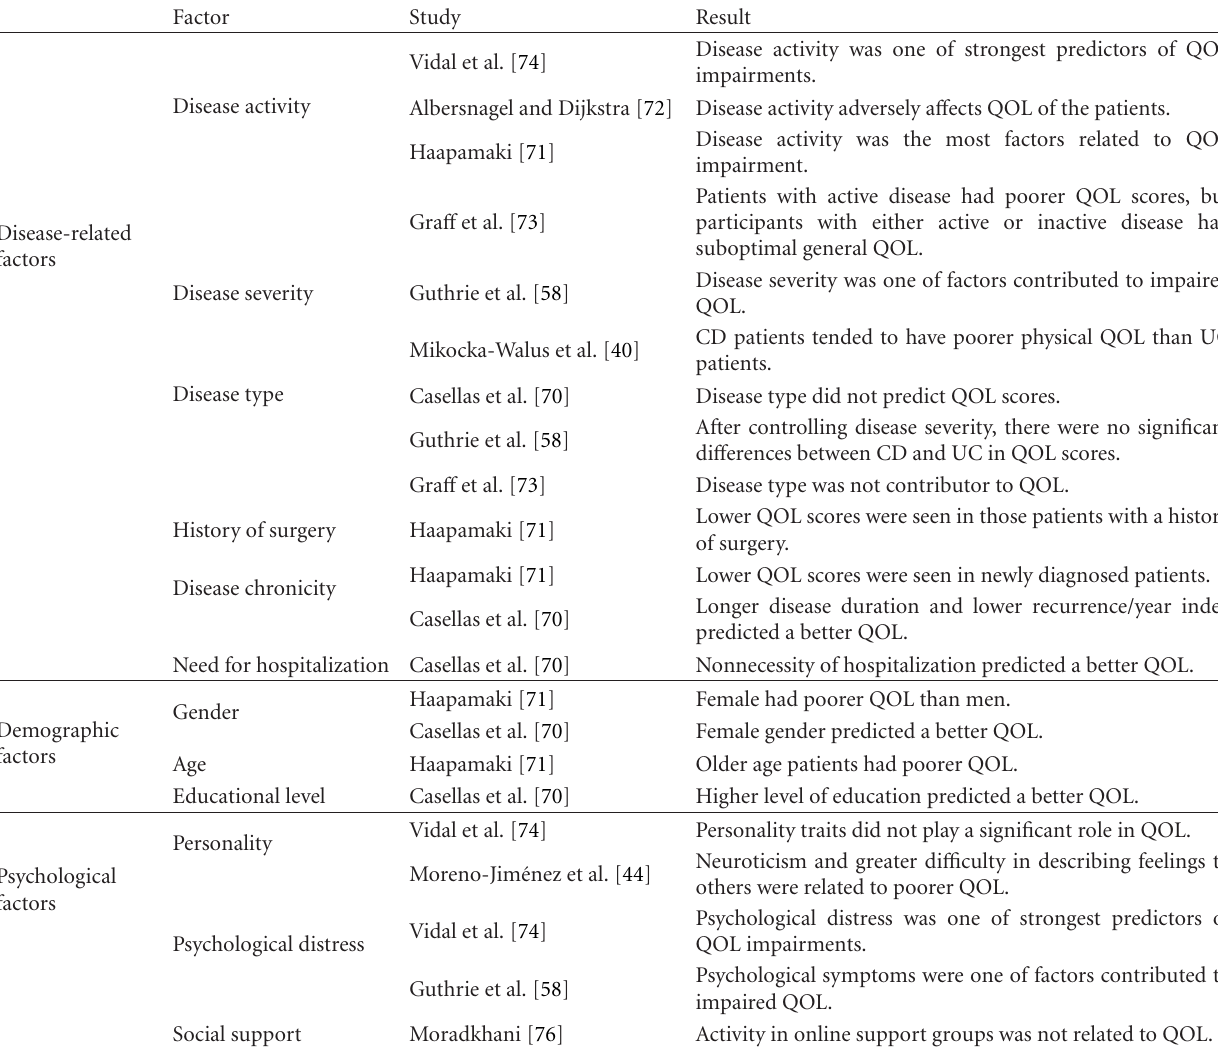
Table 1: Factors a ff ecting QOL in patients with